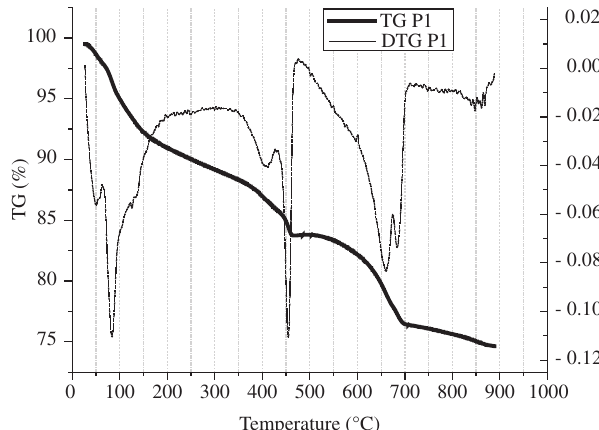
Figure 1. TG curve of the paste without polymer and 5% of silica fume P5.